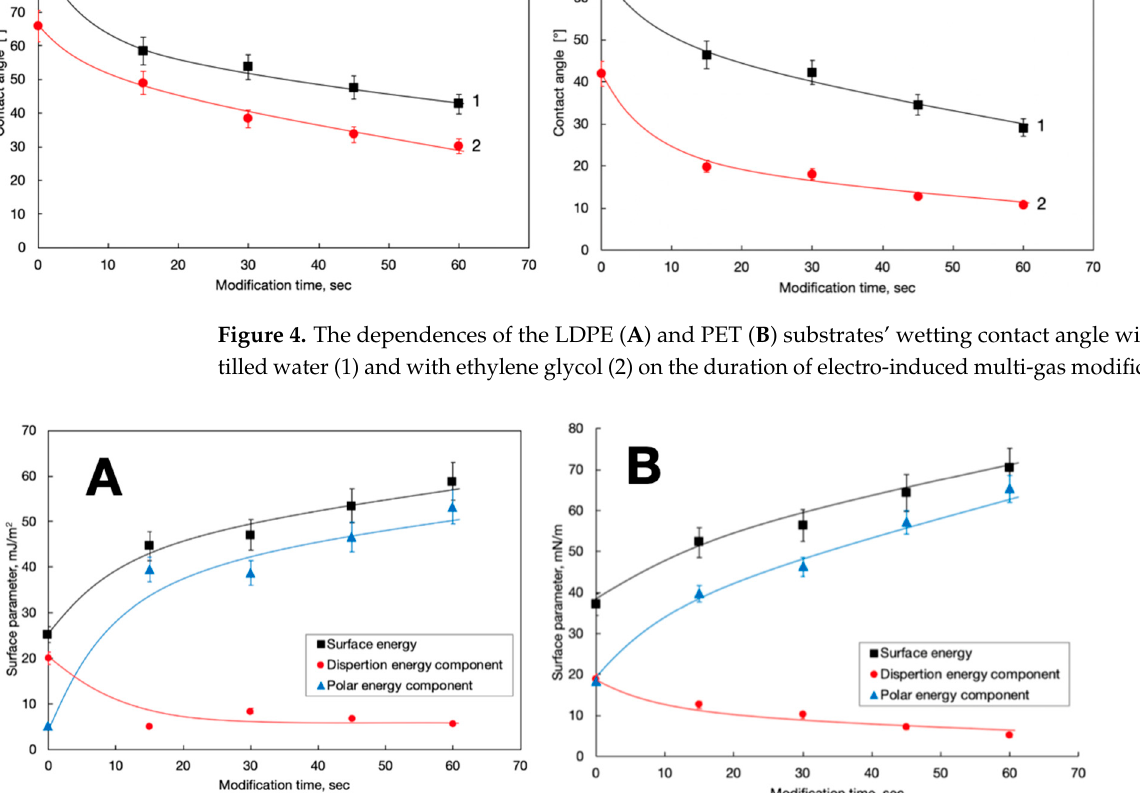
Figure 4. The dependences of the LDPE ( А ) and PET ( B ) substrates’ wetting contact angle with distilled water (1) and with ethylene glycol (2) on the duration of electro-induced multi-gas modi- fication.